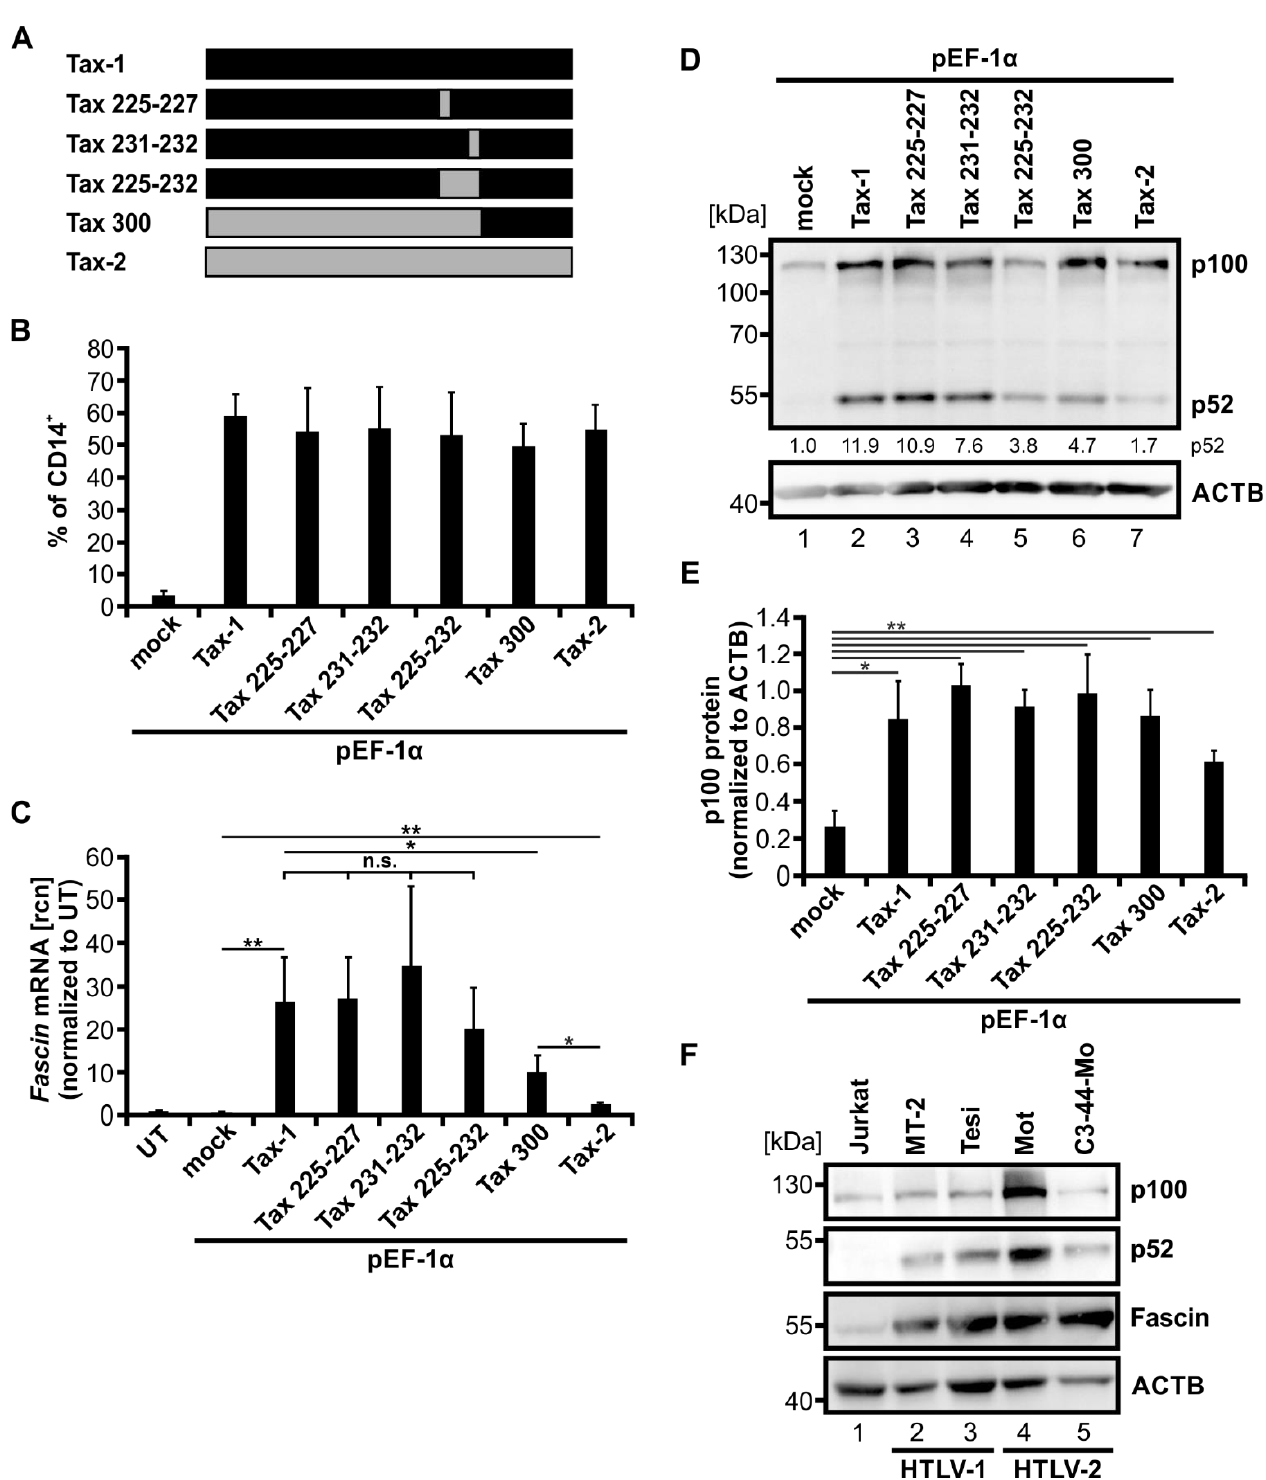
Figure 5. Tax-2 chimeras and in HTLV-2-transformed T-cells correlates with activity of the alterna- Figure 5. Fascin induction by Tax-1/Tax-2 chimeras and in HTLV-2-transformed T-cells correlates tive NF- κB signaling pathway. ( A ) Scheme of Tax-1, Tax-2, and Tax-1/Tax-2 chimeras. Exchanged with activity of the alternative NF- κ B signaling pathway. ( A ) Scheme of Tax-1, Tax-2, and Tax-1/Tax-2 amino acids in the respective mutants Tax 225-227, Tax 231-232, Tax 225-232, and Tax 300 are indi- chimeras. Exchanged amino acids in the respective mutants Tax 225-227, Tax 231-232, Tax 225-232, cated. Black and grey bars show fragments originating from Tax-1 and Tax-2, respectively. ( B ) and Tax 300 are indicated. Black and grey bars show fragments originating from Tax-1 and Tax-2, SVT35 Jurkat T-cells carrying an NF- κB -dependent CD14-reporter were transfected with either pEF- respectively. ( B ) SVT35 Jurkat T-cells carrying an NF- κ B-dependent CD14-reporter were Tax-1, pEF-Tax-2, the listed plasmids encoding chimeras of both proteins, or the mock control vector pEF- 1α (50 μg). NF - κB -driven CD14 surface expression was detected at 48 h after transfection by flow cytometry using anti-CD14 antibodies. Mean values ± SD of three independent experiments